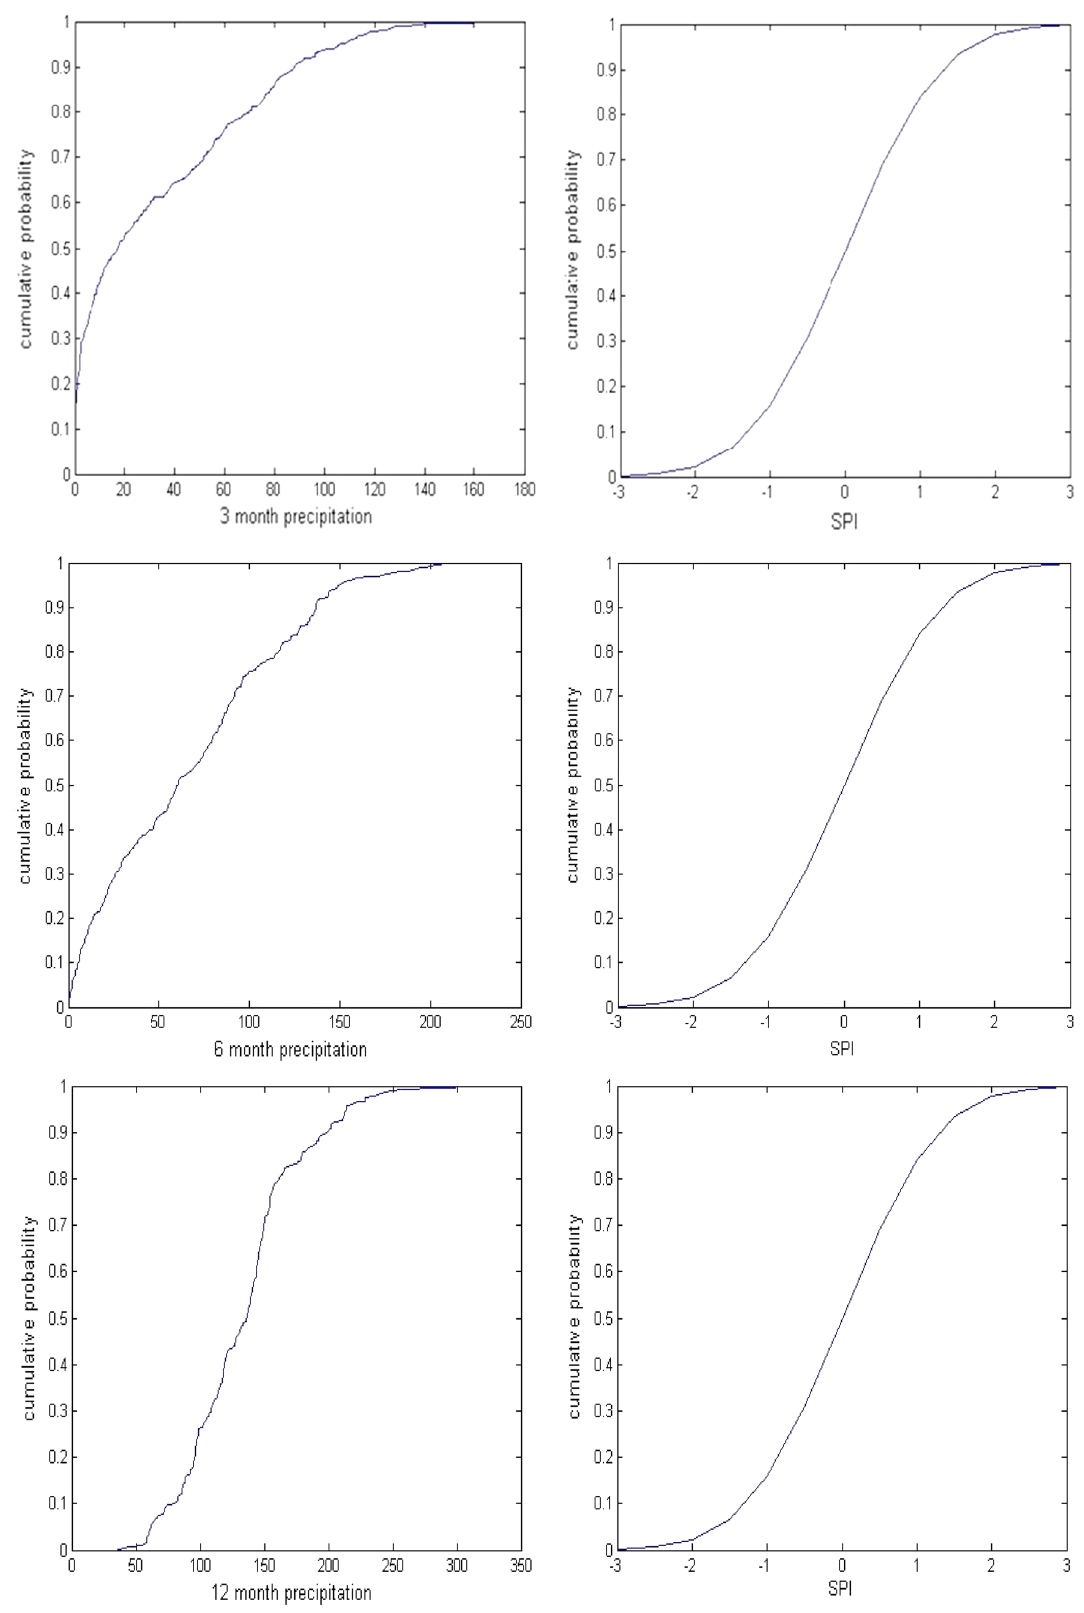
Fig. 2 The precipitation cumulative and standard normal probability distribution